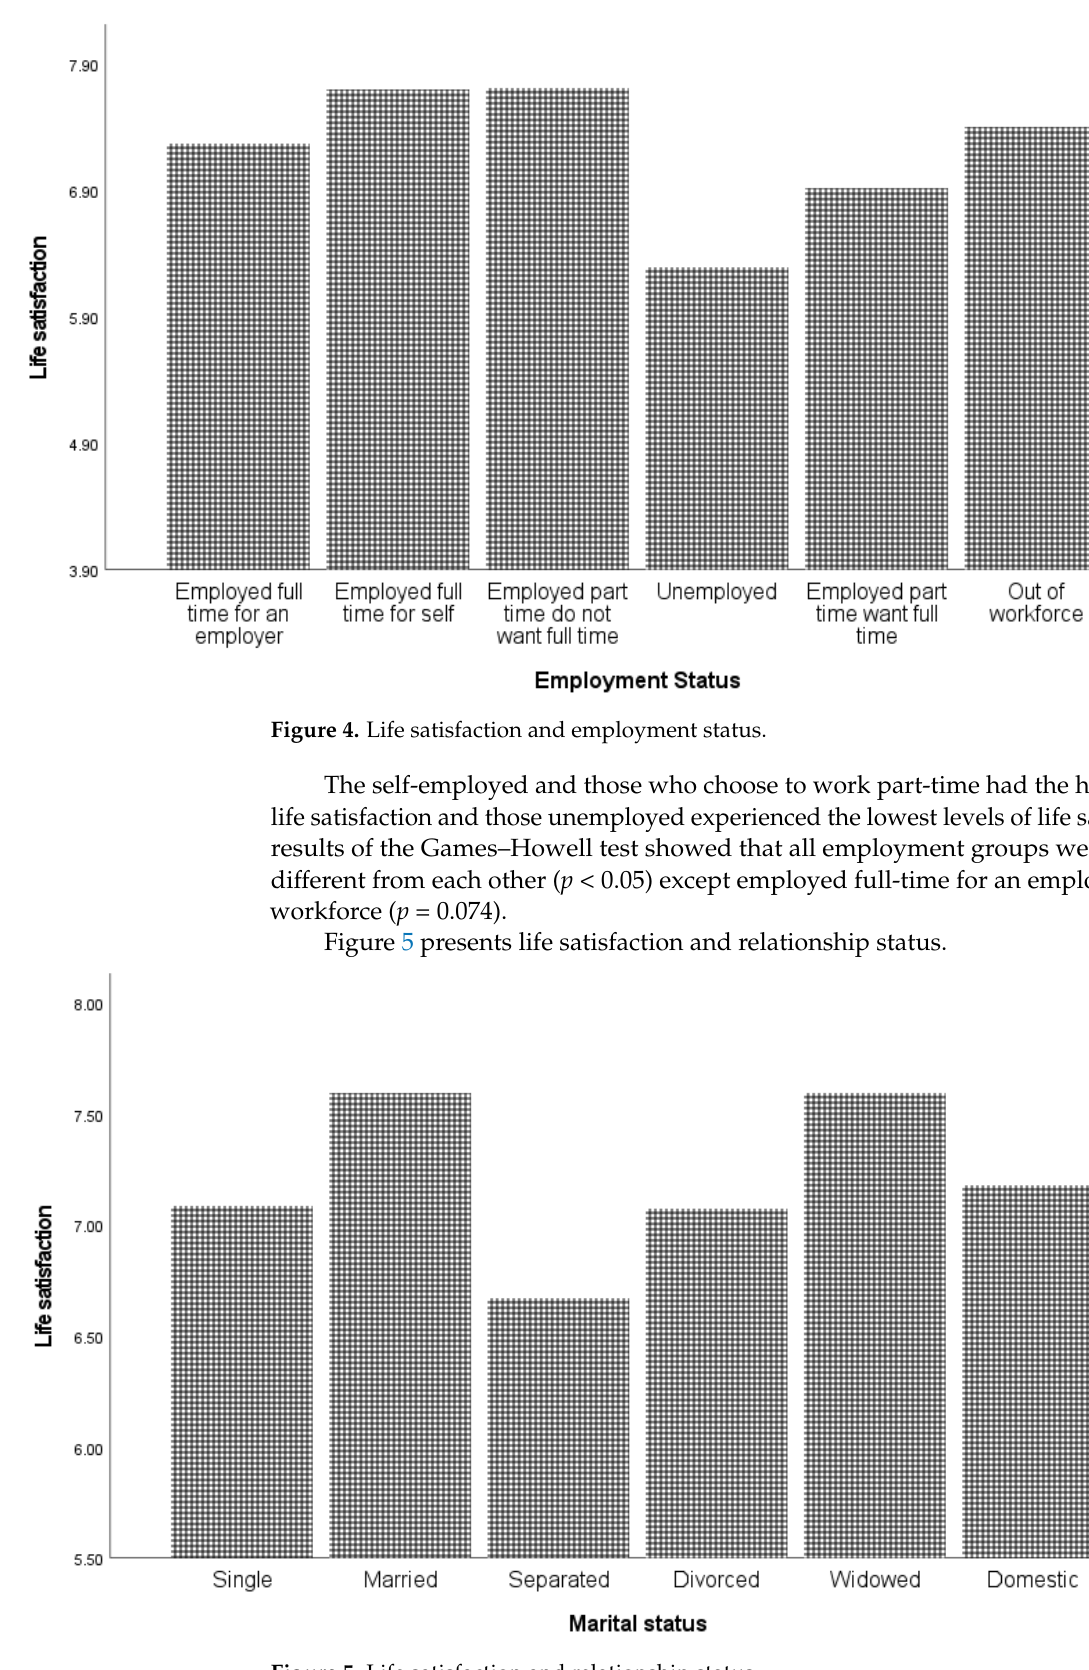
Figure 5. Life satisfaction and relationship status.